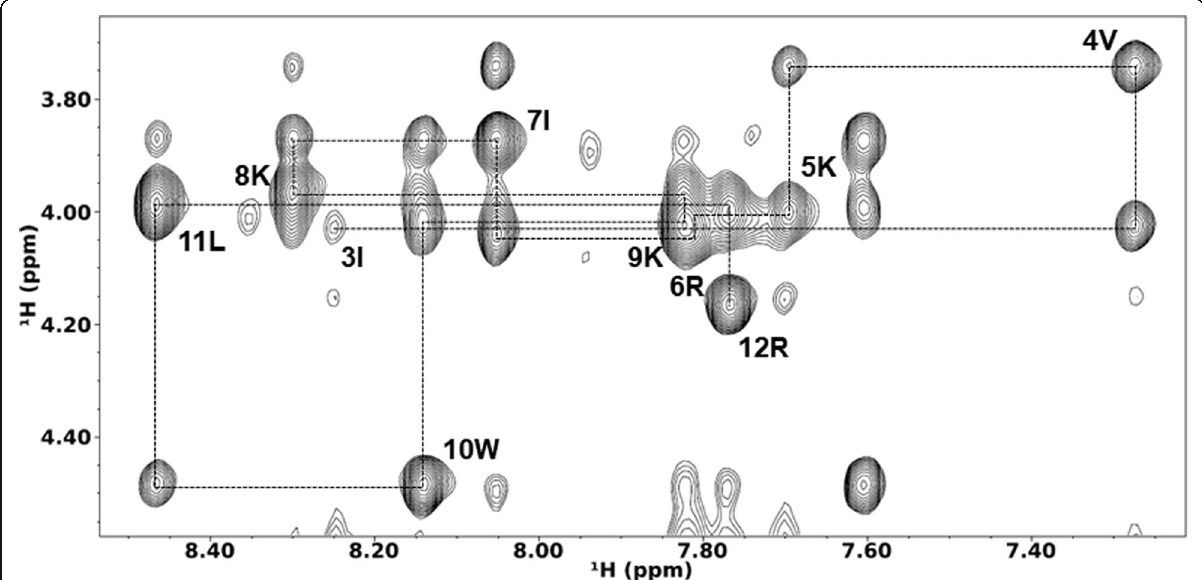
Fig. 3 Sequential d α N (i, i + 1) Nuclear Overhauser Effect (NOE) connectivities for KR-12-pa in a 1 H NOESY spectrum observed with a mixing time of 300 ms at 298 K. Intraresidue NH-C α H cross peaks are labeled with the residue number of KR-12-pa using standard single-letter amino acid